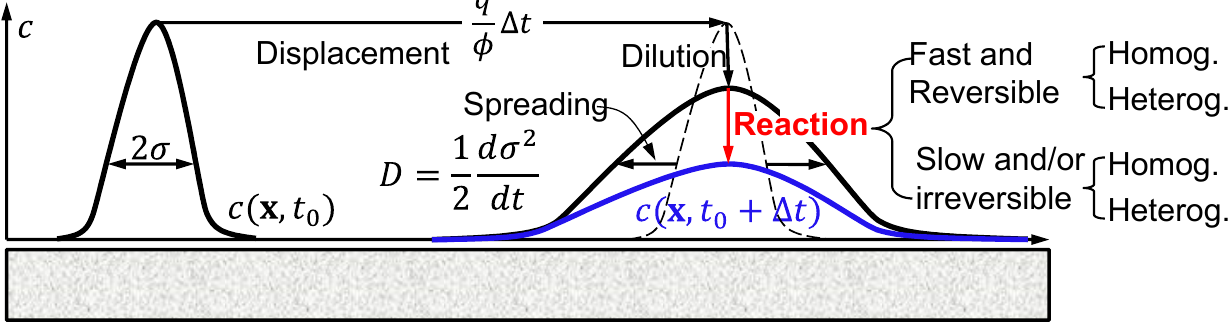
Figure 1. Reactive transport (RT) describes the transport of solutes (displacement by advection, spreading by dispersion, and dilution by mixing) and the reactions (red arrow) among solutes and with immobile phases. The mathematical nature of RT depends on the type of reactions and species involved [12].